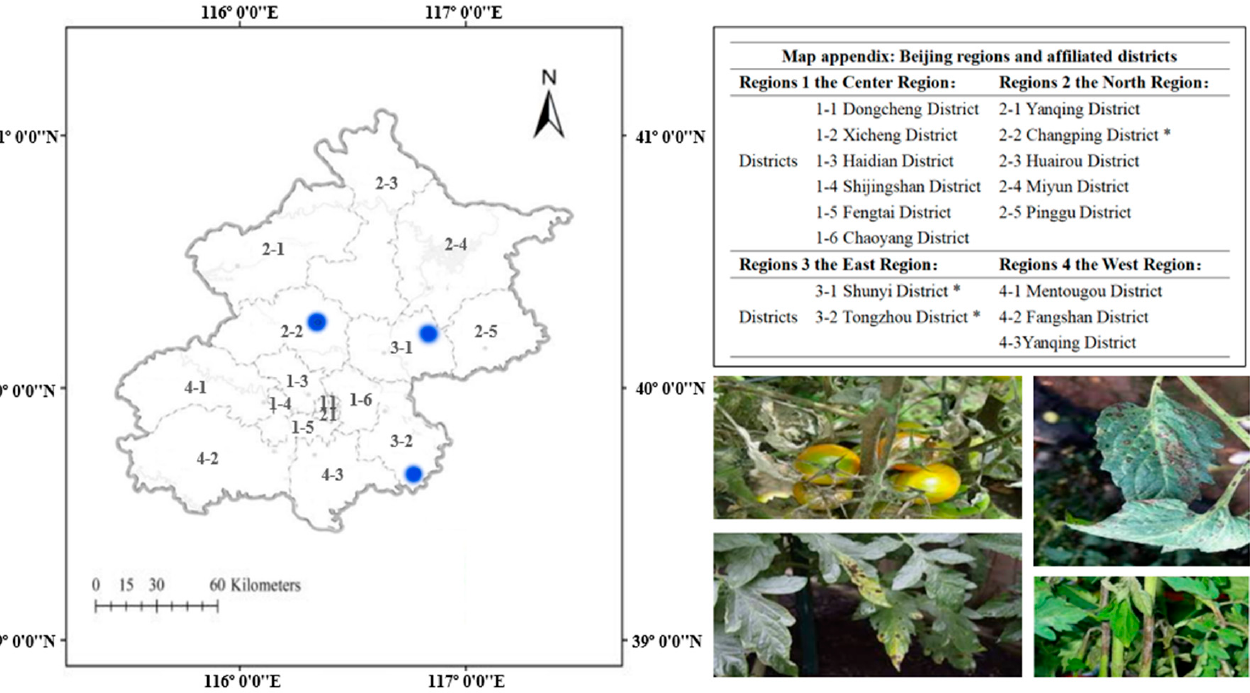
Figure 1. Beijing district map. The district number consists of two parts, namely the location regions and the functional areas. The four location regions were numbered as 1–4, in order from the city center to the suburbs. The upper right part shows the map appendix for Beijing regions and affiliated districts; the lower right part shows the tomato diseases. The * matches represent the sampled districts in the map, respectively.